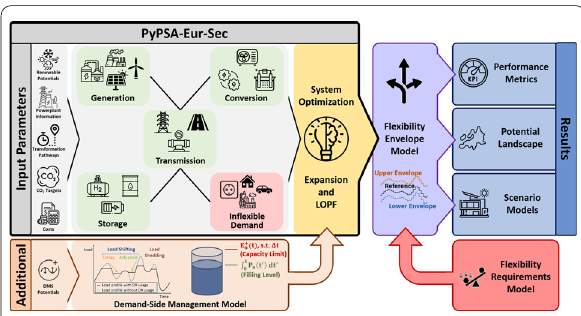
Fig. 1 Model structure of the doctoral thesis: Extension of PyPSA‑Eur‑ Sec by a simplified DSM model and analysis of the optimization results by an envelope based flexibility